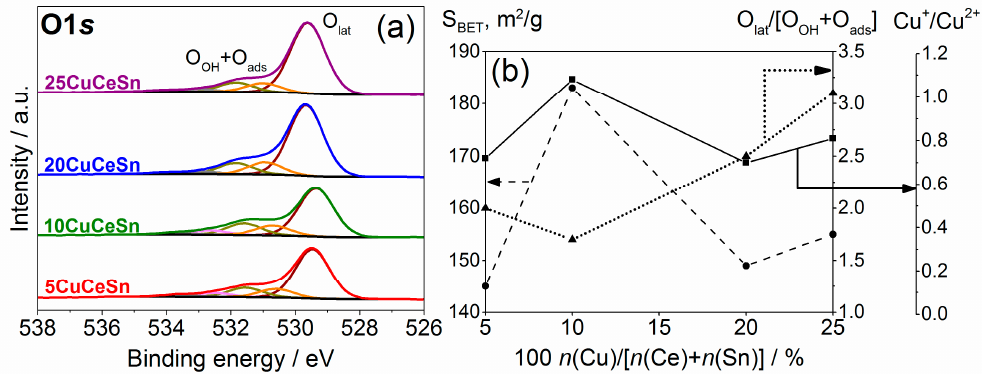
Figure 6. High-resolution O1 s XPS spectra ( a ) and a correlation between the S BET , ratio of oxygen forms, Cu + /Cu 2+ ratio measured by XPS and Cu content in one-pot synthesized CuCeSn catalysts ( b ).